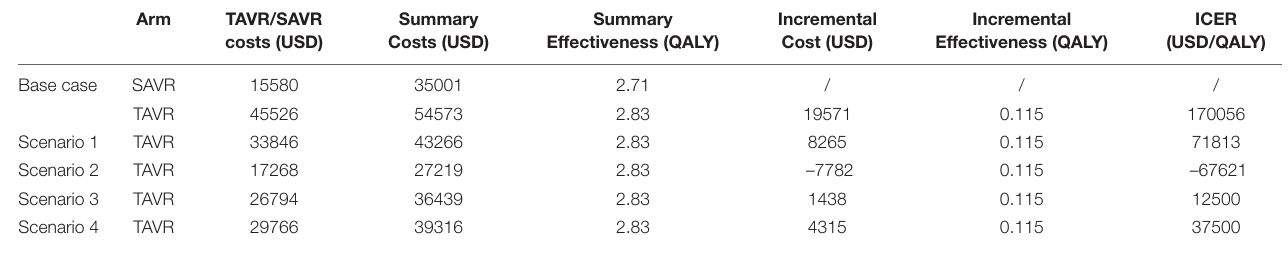
TABLE 3 | Base case and scenario analysis based on different TAVR device